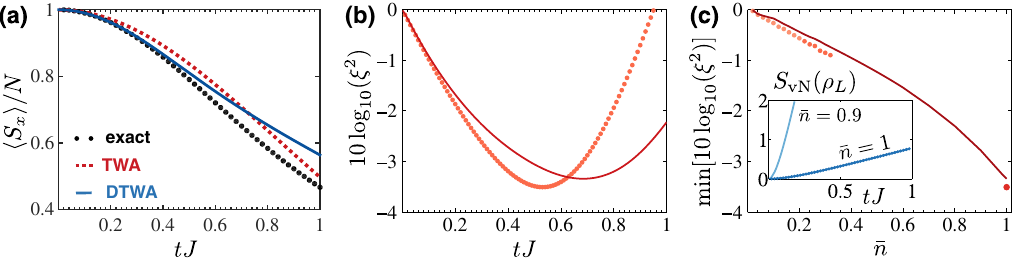
FIG. 3. Dynamics for XY interactions. Circles denote exact, solid lines DTWA, and dotted lines traditional TWA results. (a) Time evolution of h S x i for the XY model in 1D, for N ¼ 100 spins and with long-range interactions with decay exponent α ¼ 3 . In contrast to the Ising case, DTWA is exact for short times only but can capture longer times than traditional TWA. (b) Time evolution of the spin- squeezing parameter ξ . The DTWA gives exact results for short times and good estimates for the achievable ξ . (b) Achievable ξ as a function of the filling fraction (averaged over 1000 random configurations). Exact diagonalization for N < 20 , tDMRG otherwise. Inset: Rapid increase of the entanglement entropy for noninteger filling ¯ n < 1 (single configuration), rendering tDMRG calculations inefficient in this